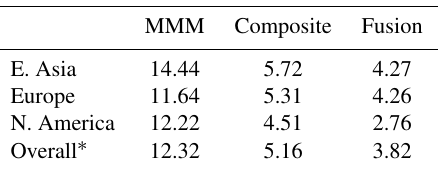
Table 3. RMSE against TOAR observations (i.e., not interpolated ozone) from the multi-model mean (MMM), multi-model compos- ite (from fusion step 2) and the final fused product (from fusion step